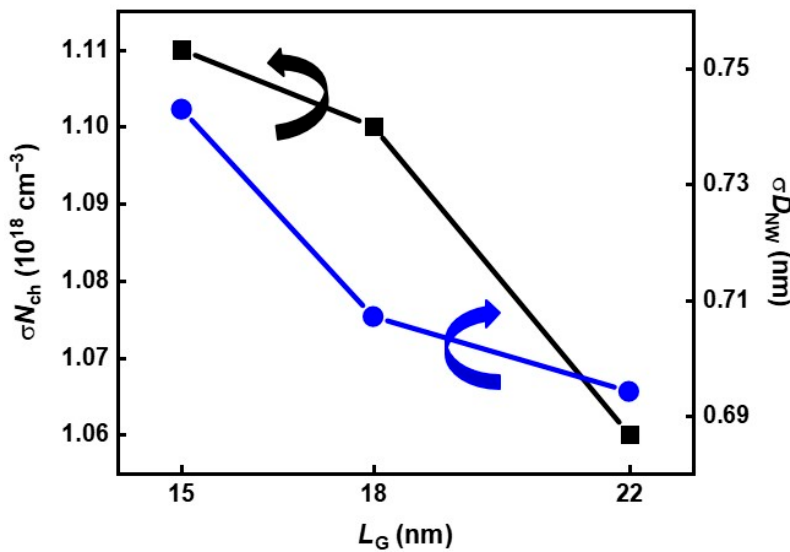
Figure 8. Extracted σ N ch (black line) and σ D NW (blue line) as function of L G .